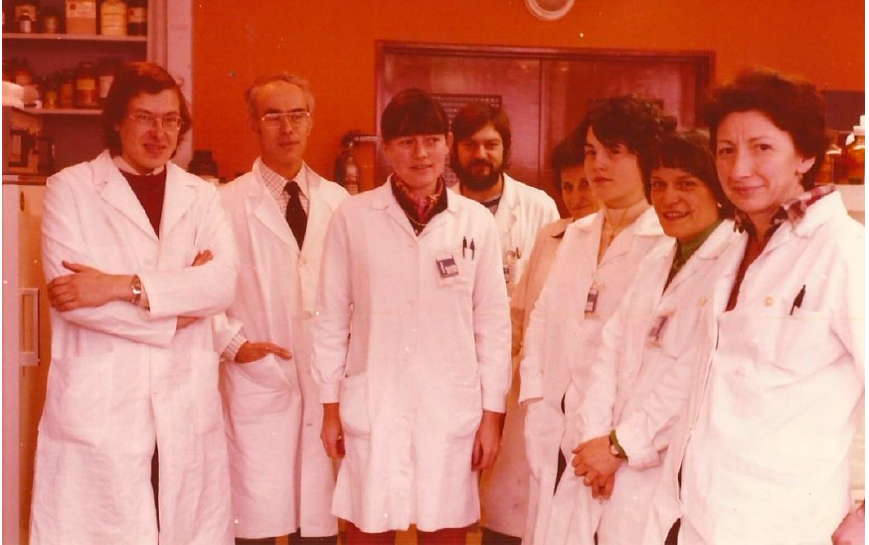
Figure 2. From 1976 to 1978, Bob worked mainly on the C1 complex and C1-inhibitor in the Centre d’Etudes Nucleaires in Grenoble in the laboratory of Maurice Colomb (white coats were compulsory). This work was important in Bob’s subsequent interaction with John Jackson from Dublin in determining the cause of autoimmune angioedema. From left to right are Bob Sim, Maurice Colomb, Angeline Reboul, Gerard Arlaud, Renee Ducret, Marie Bernadette Villiers, Mme Dodu and Mme Duplas.